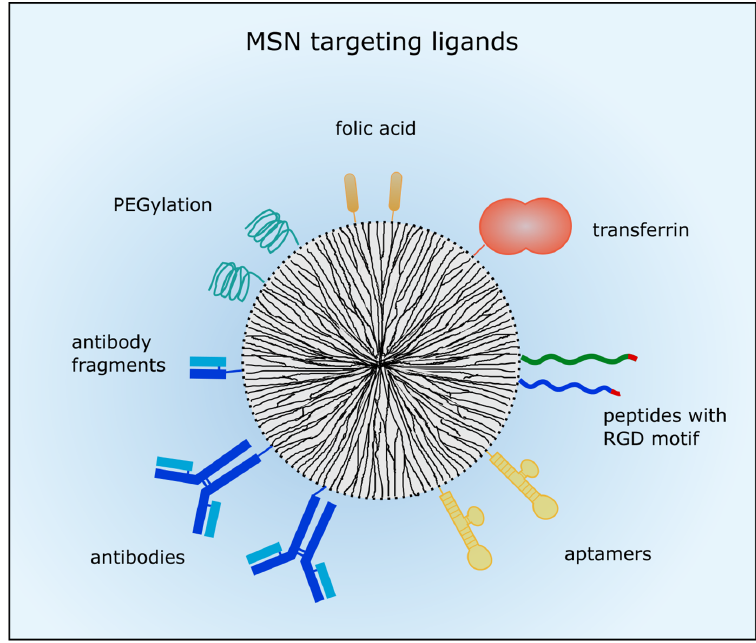
Figure 1. Ligands for active tumor targeting. MSN can be coated with poly (ethylene glycol) (PEG) to prolong circulation time. Small molecules such as folic acid are often used for active targeting. Different peptides with the arginine ‐ glycine ‐ aspartic acid (RGD) motif or proteins such as transferrin were also employed for tumor targeting. Moreover, aptamers, antibodies or antibody fragments are utilized to target membrane ‐ receptors which are commonly overexpressed in cancer cells.